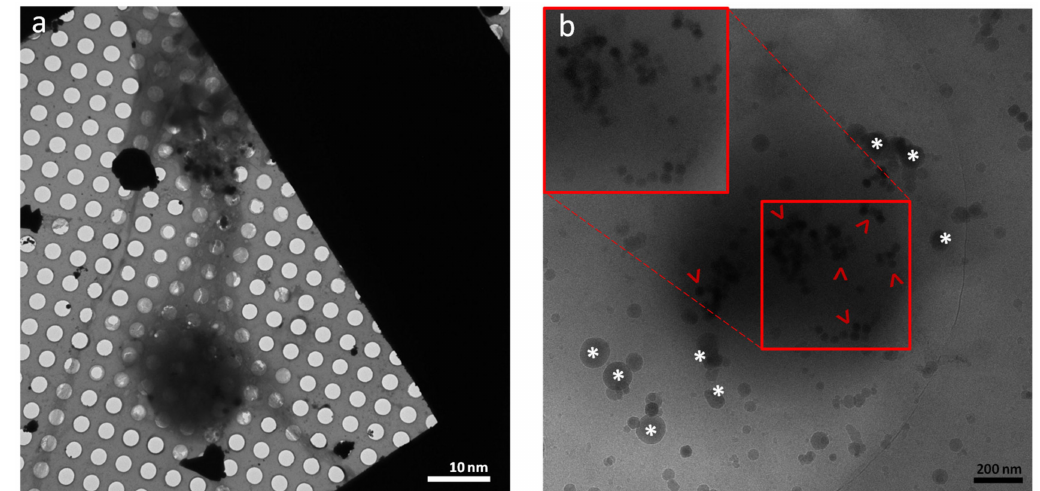
Figure 4. ( a ) Low-magnification cryo-EM image of vitrified differentiated SH-SH5Y cells with dendrite-like extensions on top of the TEM grid; ( b ) surface of a dense organelle that is coated with peptide/antibody-modified UCNPs (red arrowheads). Inserted red boxes show a relatively higher magnification and contrast of UCNPs. Ice crystals are labeled with white asterisks.